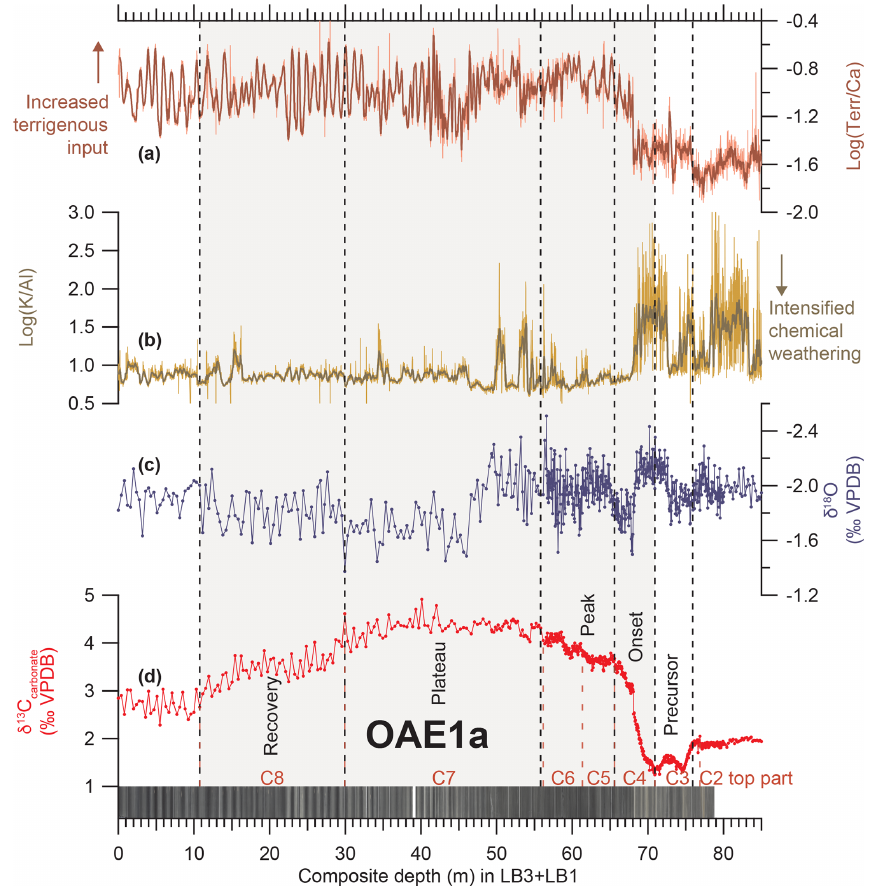
Figure 3. Line scan photographs, stable isotope and XRF scanning elemental records spanning OAE1a from La Bédoule Cores LB3–LB1. (a) Log(Terr / Ca). (b) Log(K / Al). (c) δ 13 O and (d) δ 13 C carbonate from Lorenzen et al. (2013) and Moullade et al. (2015) with new high- resolution isotope data from this study. The boundaries between individual phases (precursor, onset, peak, plateau, recovery) of OAE1a are indicated by dashed black lines. Carbon isotope stages C2–C8 of Menegatti et al. (1998) are indicated by red